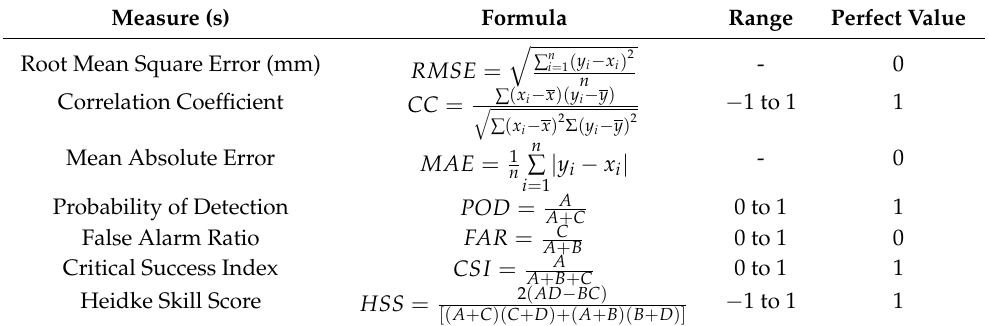
Table 3. Statistical and contingency measures and their calculation formulas, ranges, and best